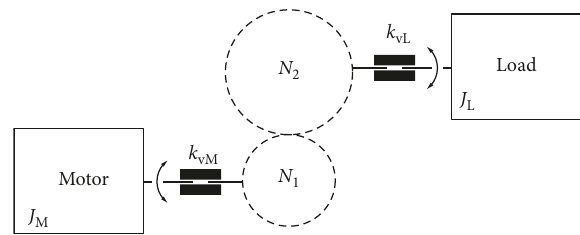
Figure 4: Schematic of the motor and load connected by a re- duction box.